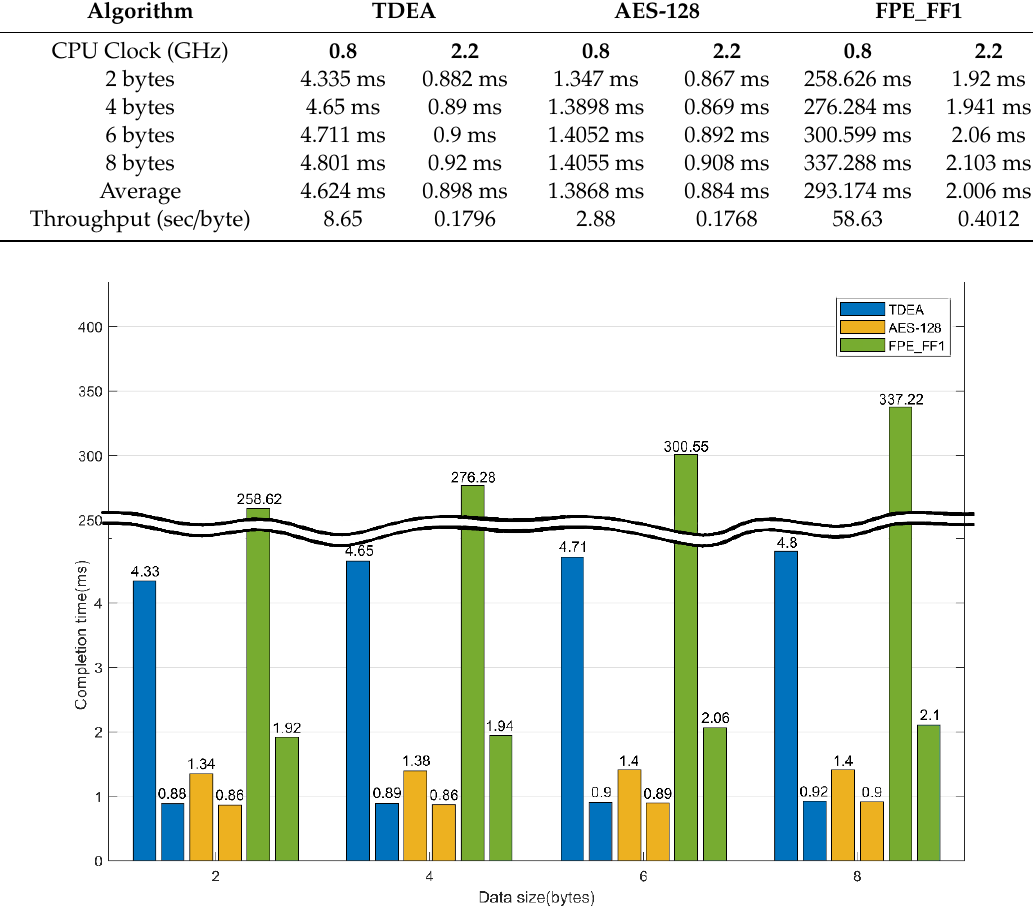
Figure 7. Encryption time comparison at 0.8 and 2.2 Ghz.